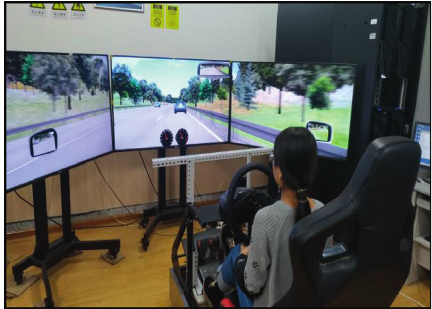
Figure 2: Driving simulator and experimental